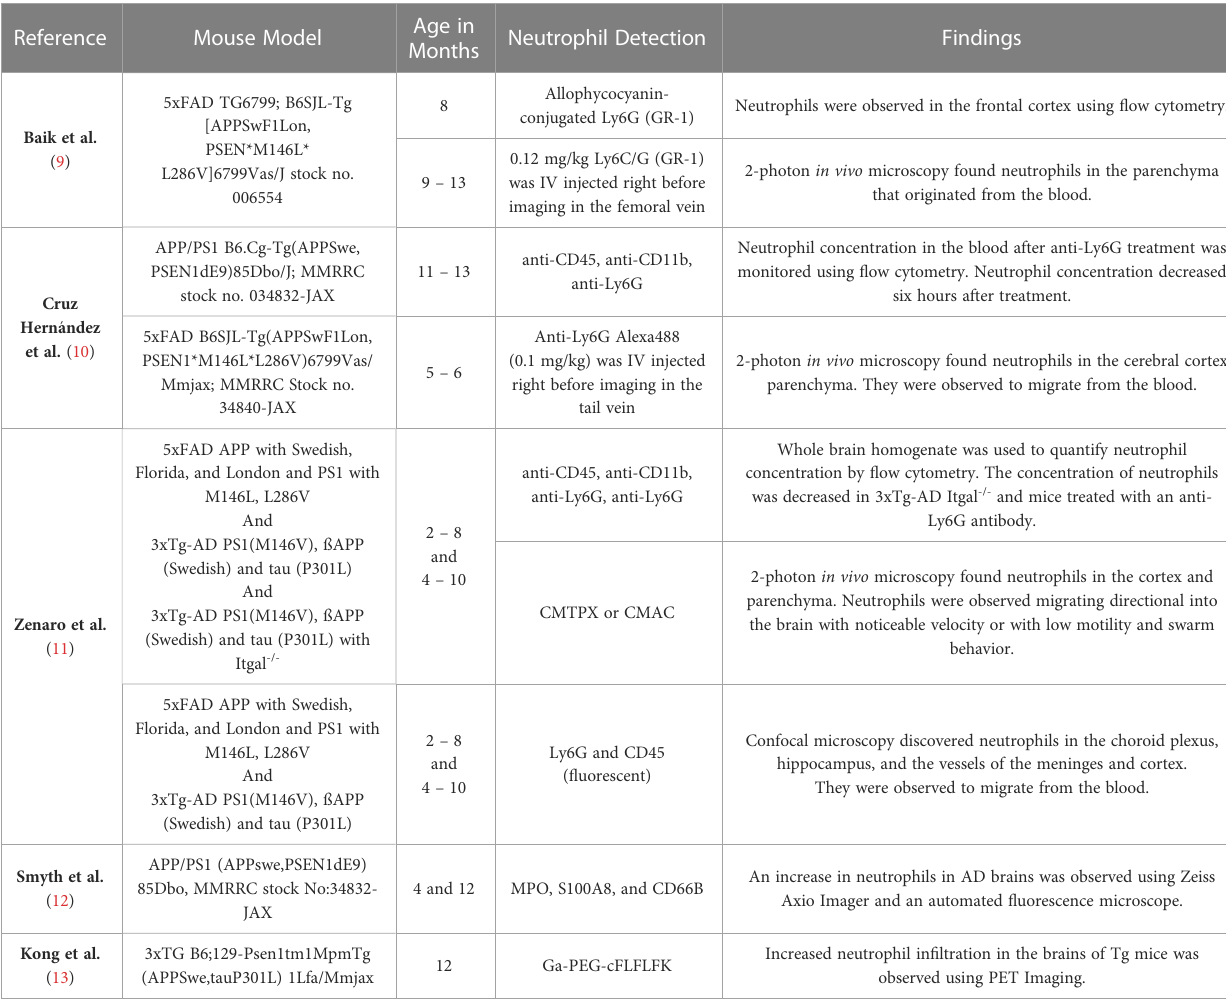
TABLE 1 Alzheimer ’ s Disease Mouse Model